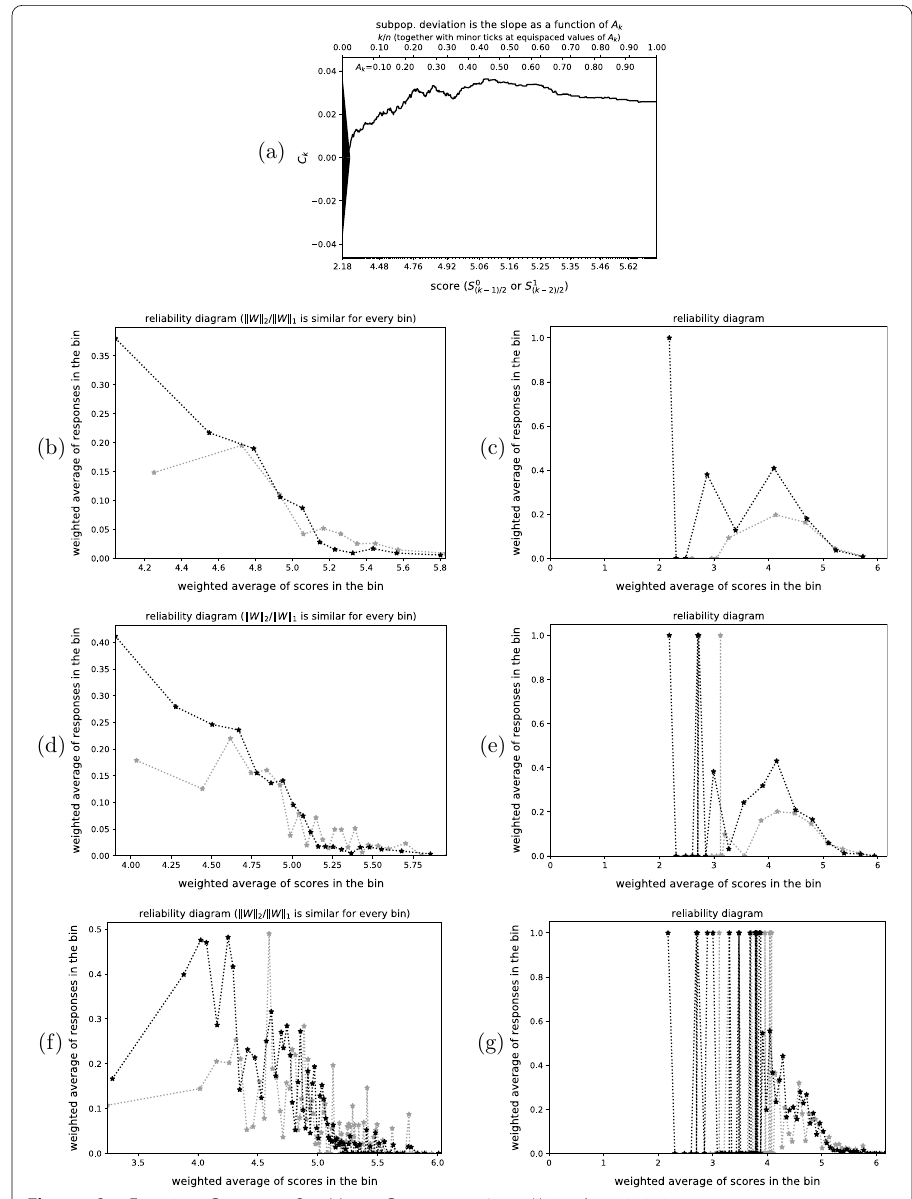
Fig. 14 San Francisco County vs. San Mateo County; n = 3147; Kuiper’s statistic is 0.03688 /σ = 1.923 , Kolmogorov’s and Smirnov’s is 0.03631 /σ = 1.893 ; resolving the full extent of the spike at some of the lowest scores in the cumulative graph ( a ) requires at least 100 bins in the reliability diagrams ( f and g ), but then the reliability diagrams are too noisy at the other scores. The statistics of Kuiper and of Kolmogorov and Smirnov do not report very statistically significant deviation between the